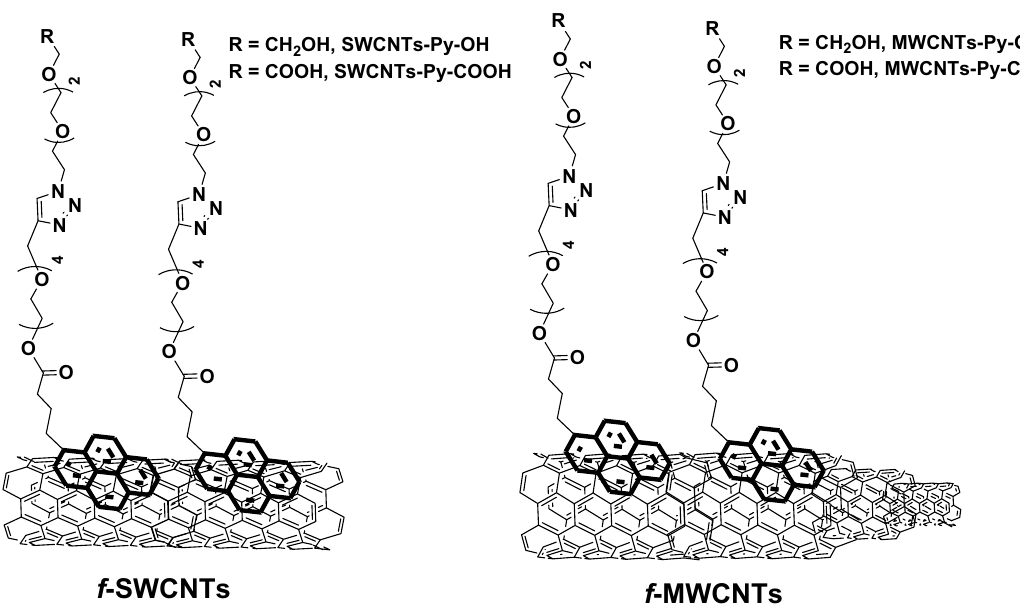
Figure 4. The scheme demonstrates the non-covalent functionalization of SWCNTs (left) and MWCNTs (right) with the hydroxyl group (SWCNTs-py-OH & MWCNTs-py-OH) and a carboxyl group (SWCNTs-Py-COOH &